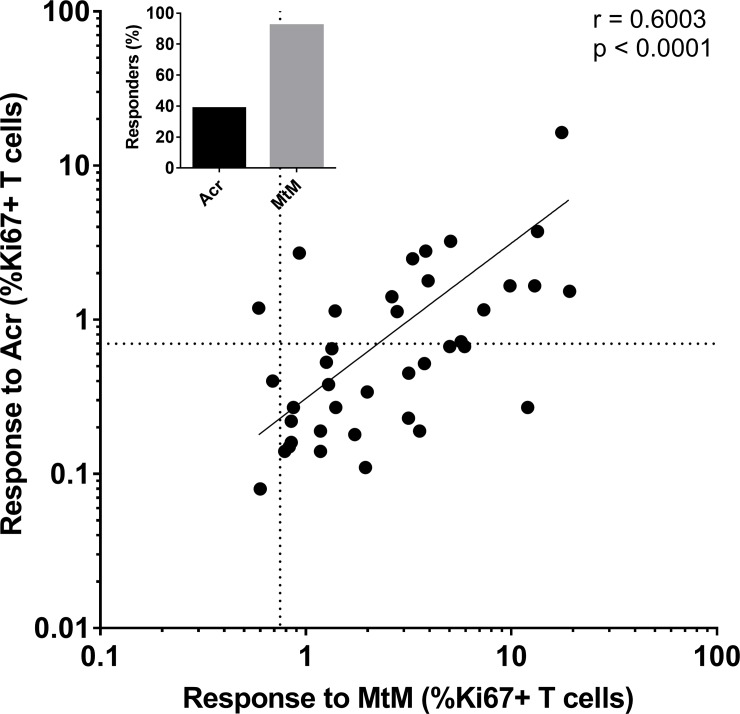
Correlation (Spearman’s r = 0.60, P < 0.0001) between T cell responses to Acr and MtM in HCWs (pooled data, n = 39).The responses to MtM were taken from our earlier report [10]. Dotted lines represent cutoffs for a positive response to either antigen. Inset figure depicts % responders for each antigen.